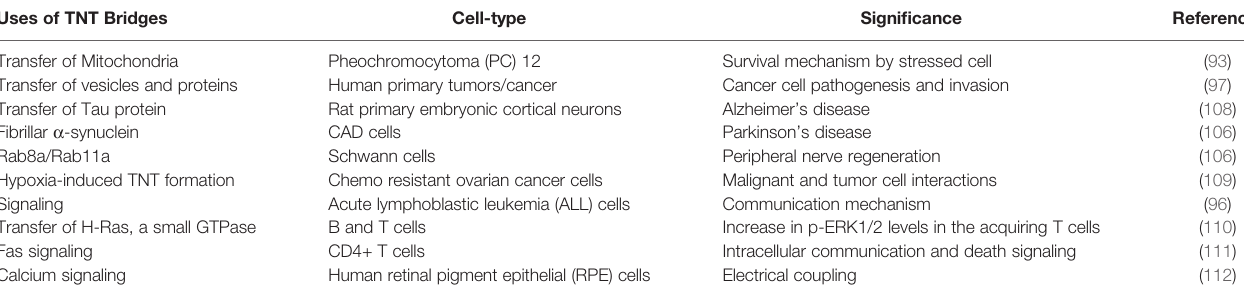
TABLE 2 | Signi fi cance of TNTs in cancers and neurodegenerative diseases including the cell-type associated with TNT bridges are listed. Uses of TNT Bridges